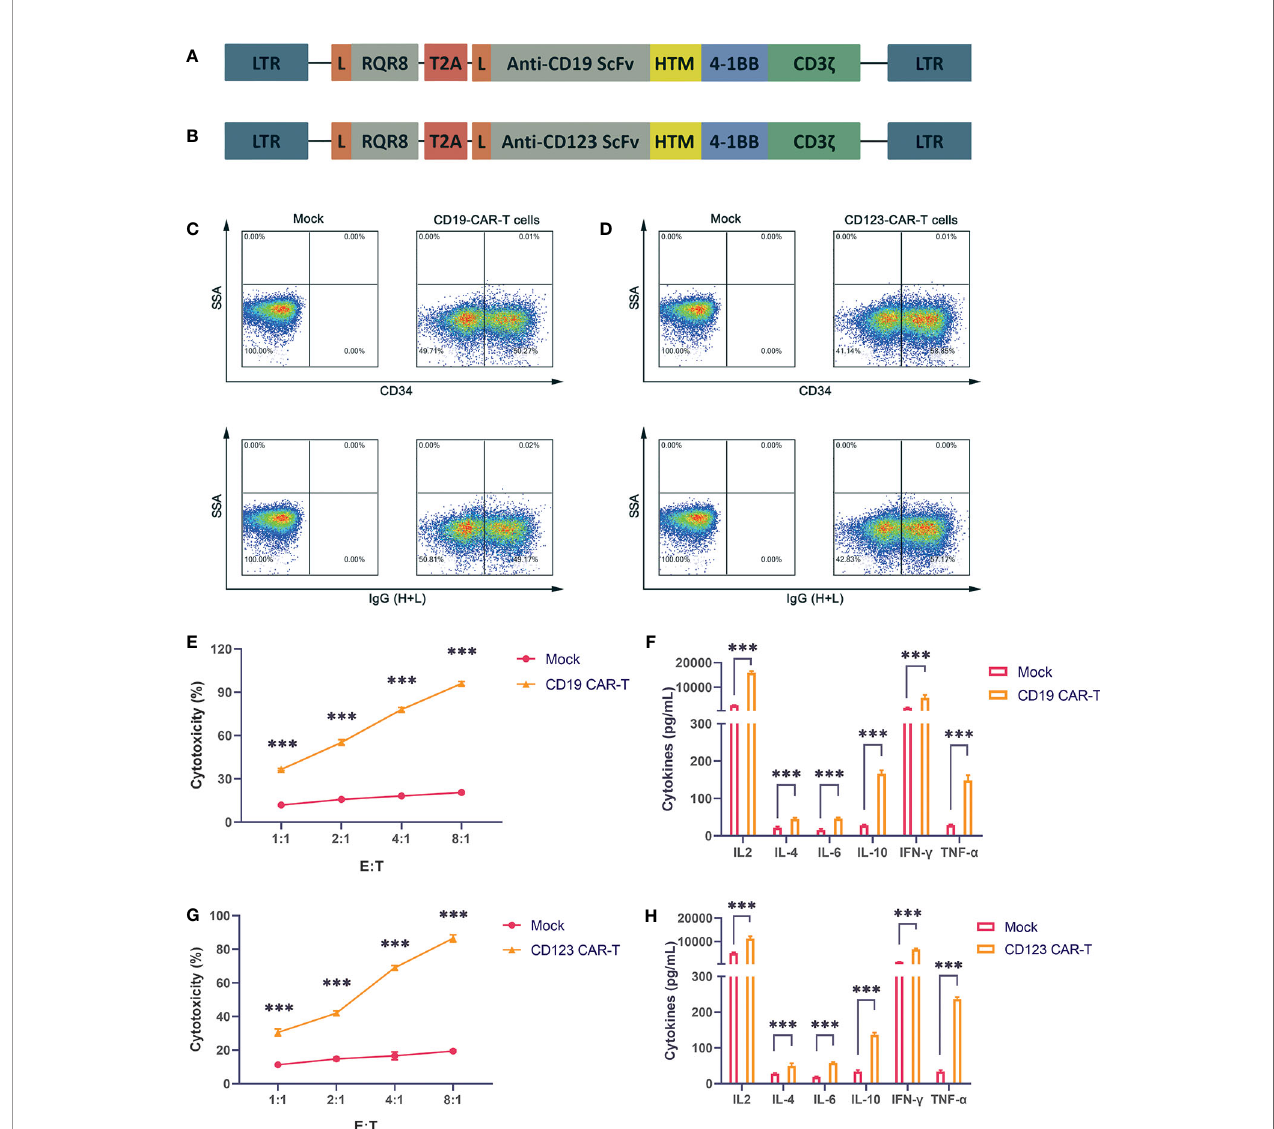
FIGURE 1 | Successful production of well-functioning CAR-T cells (A) CD19 CAR vector schematic diagram. HTM is the CD8 hinge and transmembrane region. (B) CD123 CAR vector schematic diagram. (C) Anti-CD34 antibody and anti-IgG (H+L) antibody labeling of CAR-T cells, and detection of the infection rate of CD19 CAR-T cells by fl ow cytometry. (D) Anti-CD34 antibody and anti-IgG (H+L) antibody labeling of CAR-T cells, and detection of the infection ef fi ciency of CD123 CAR-T cells by fl ow cytometry. (E) Cytotoxicity of CD19 CAR-T cells and CD19-positive NALM-6 cells coincubated at different effector:target (E:T) ratios for 24 hours. (F) Coincubation of CD19 CAR-T cells and CD19-positive NALM-6 cells at a 1:1 ratio, and detection of the secretion levels of IL-2, IL-4, IL-6, IL-10, IFN- g and TNF a in the supernatant. (G) Cytotoxicity of CD123 CAR-T cells and CD123-positive MOLM-13 cells coincubated at different E:T ratios for 24 hours. (H) Coincubation of CD123 CAR-T cells and CD123-positive MOLM-13 cells at a 1:1 ratio, and detection of the secretion levels of IL-2, IL-4, IL-6, IL-10, IFN- g and TNF a in the supernatant. Three independent experiments were conducted. Mean ± SD. ***p <